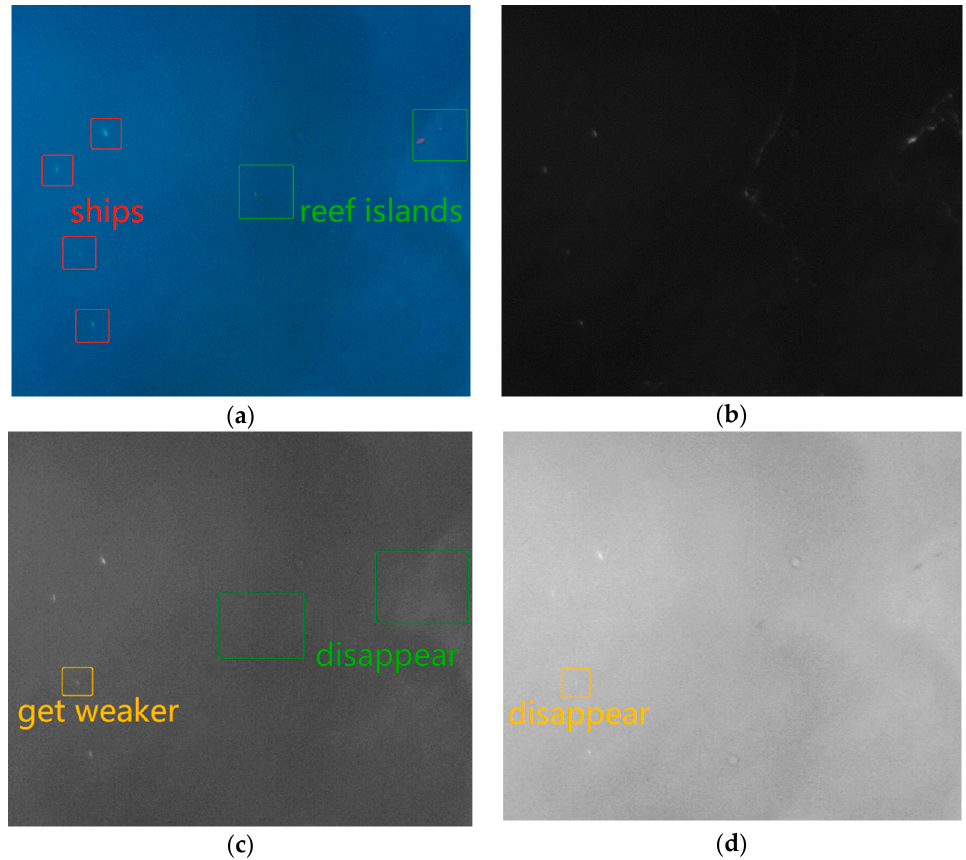
Figure 5. Multispectral radiation characteristics of different targets: ( a ) GF-4 false-color image (i.e., composites of near-infrared (NIR), red and green bands); ( b ) corresponding NIR band; ( c ) the red band; ( d ) the green band.